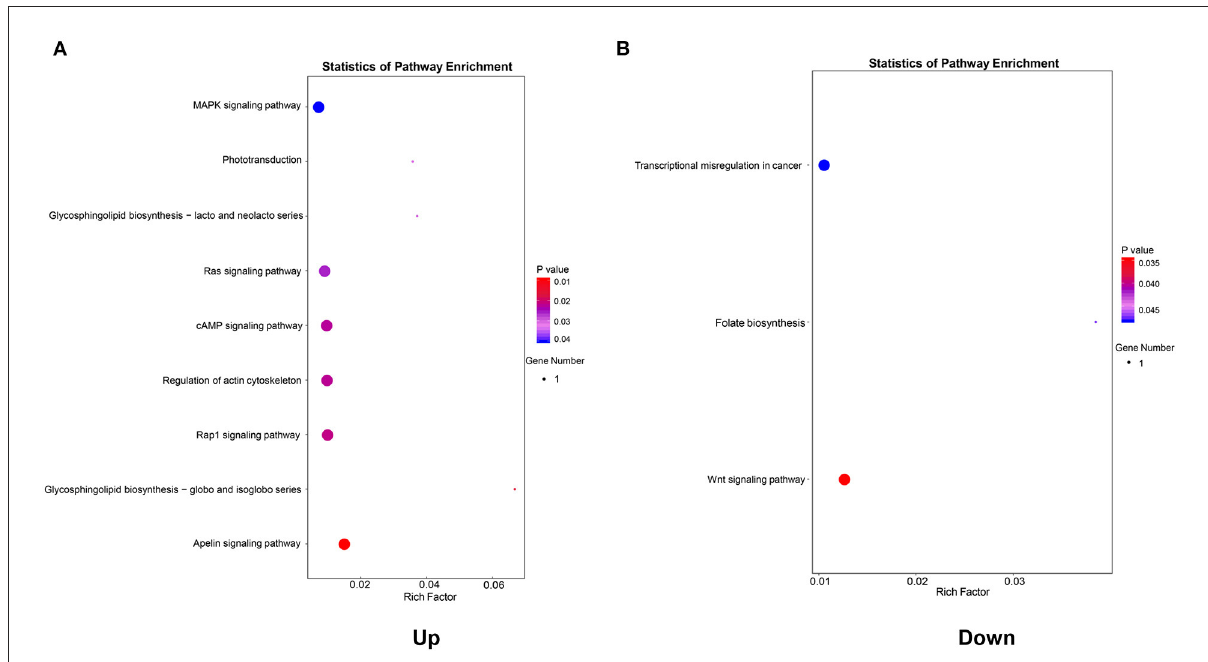
FIGURE6 Kyoto Encyclopedia of Genes and Genomes (KEGG) pathway enrichment analysis of genes in the co-expression network. (A) KEGG pathways enriched by genes in the upregulated co-expression network. (B) KEGG pathways enriched by genes in the downregulated co-expression